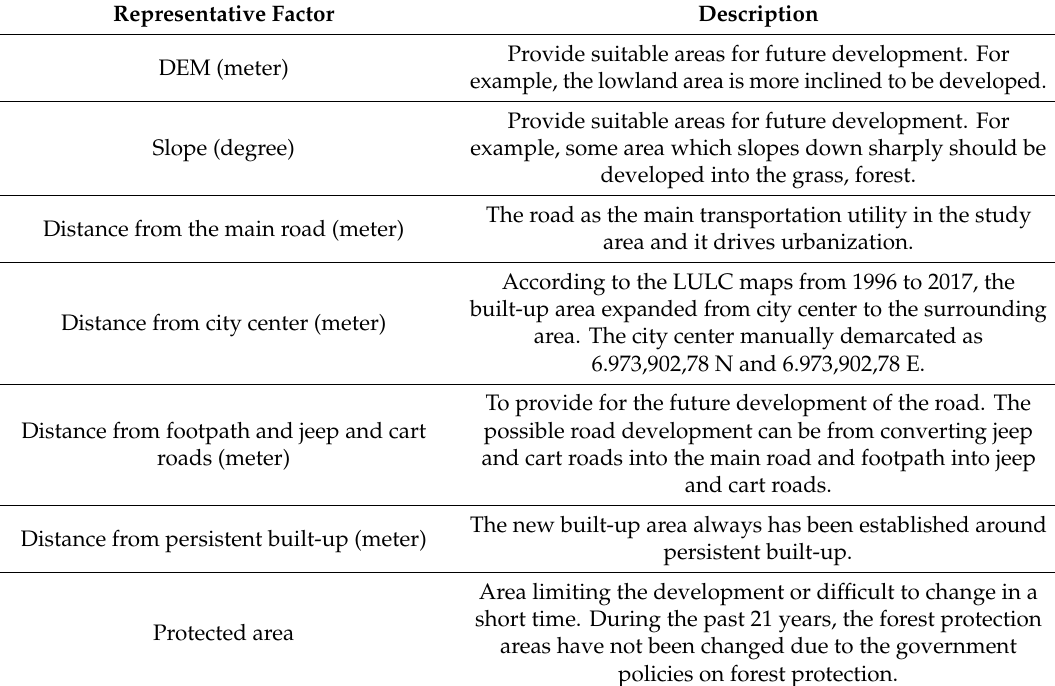
Table 3. Description and importance of selected modeling